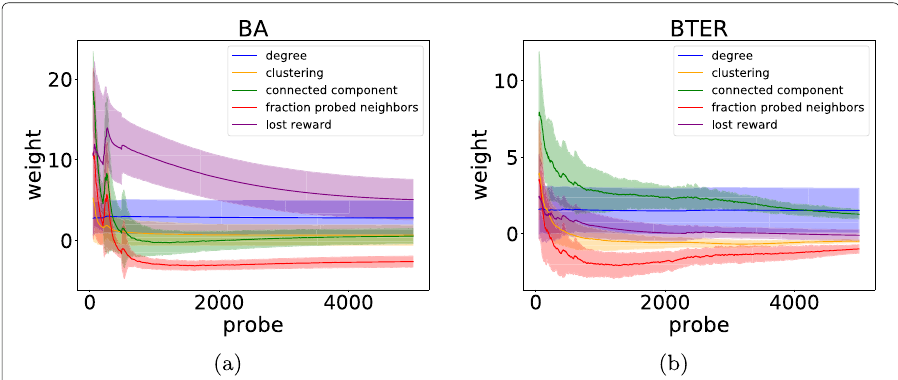
Fig. 8 Feature weights over time averaged over 20 runs of NOL-HTR on a BA and b BTER networks. In the BA network, the lost reward feature is weighted highly, consistent with many queried nodes connecting to a hub node before it is queried. In the BTER network, which is made up of Erdos-Renyi graphs with sizes following a heavy tail, the size of the connected component a node connects to is important for predicting reward, indicating preference for the largest community. Insights like these can help in both guiding feature selection and helping understand the structure of a partially observed